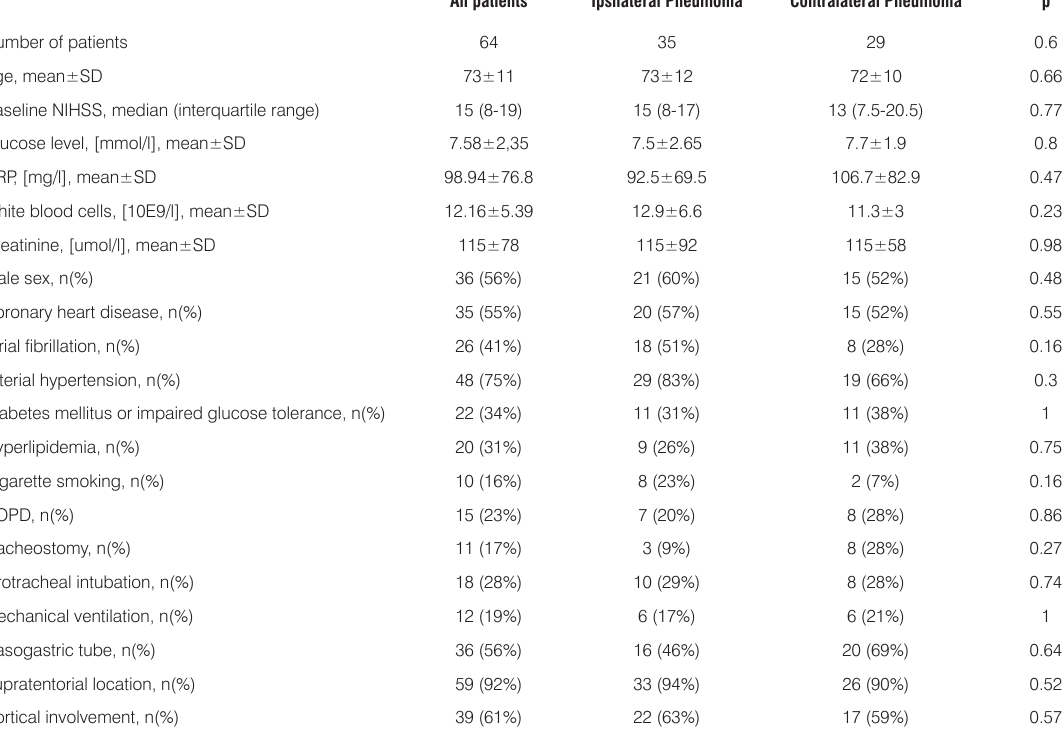
Table 1. Patient characteristics according to location of pneumonia relative to